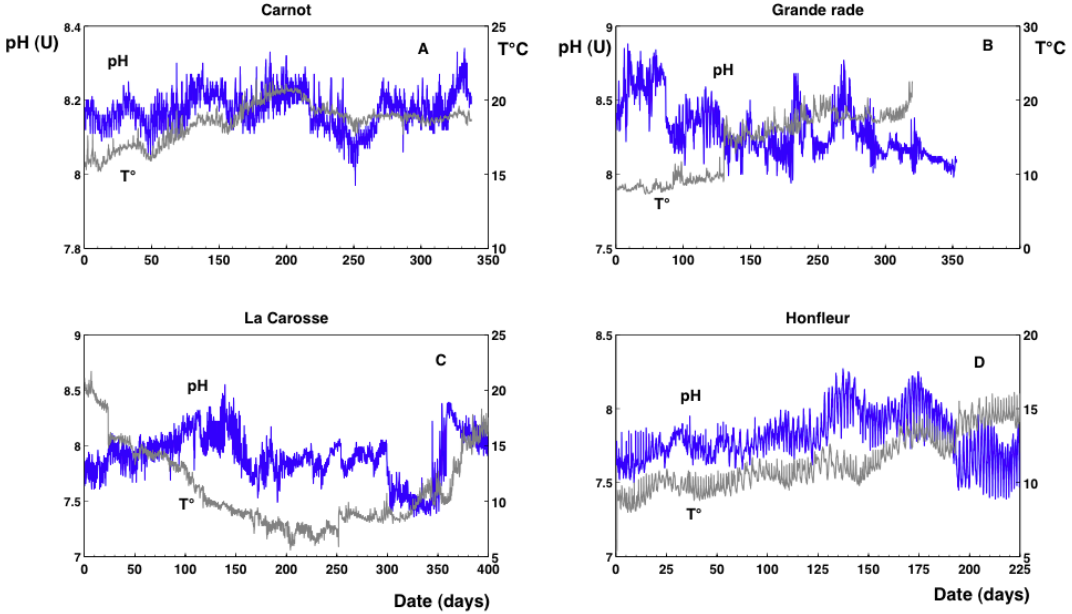
Fig. 2. A portion of pH time series for all databases considered here: (A) Carnot; (B) Grande rade; (C) La Carosse and (D) Honfleur. These plots show the high variability of pH time